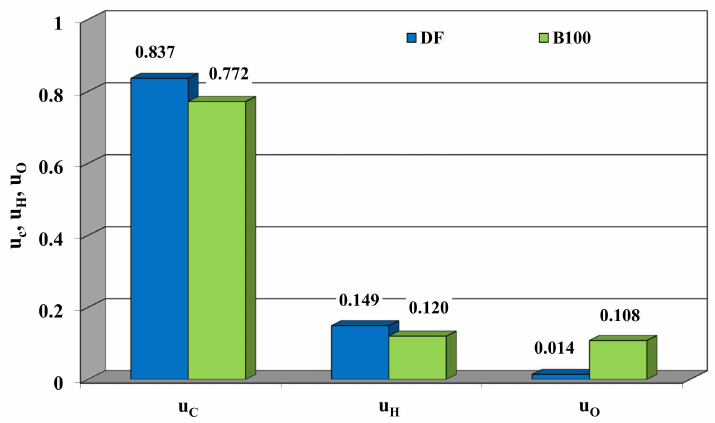
Figure 1. Elemental composition of the fuels